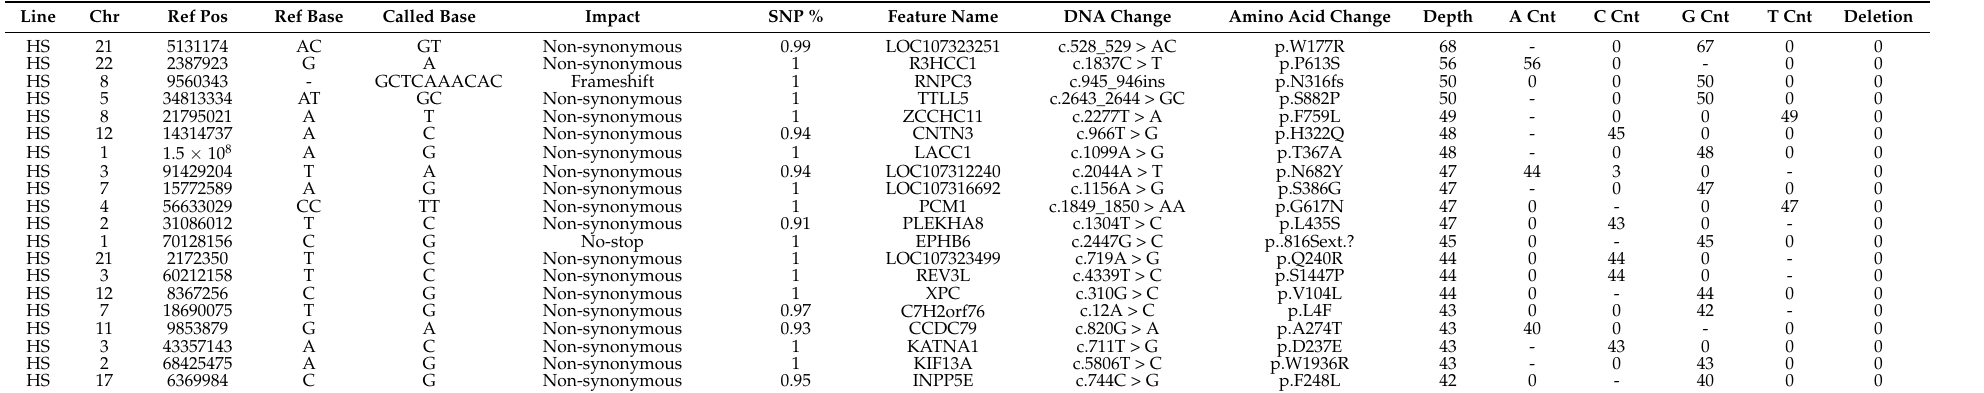
Table 2. Top 20 SNPs with the highest read depths in HS line.